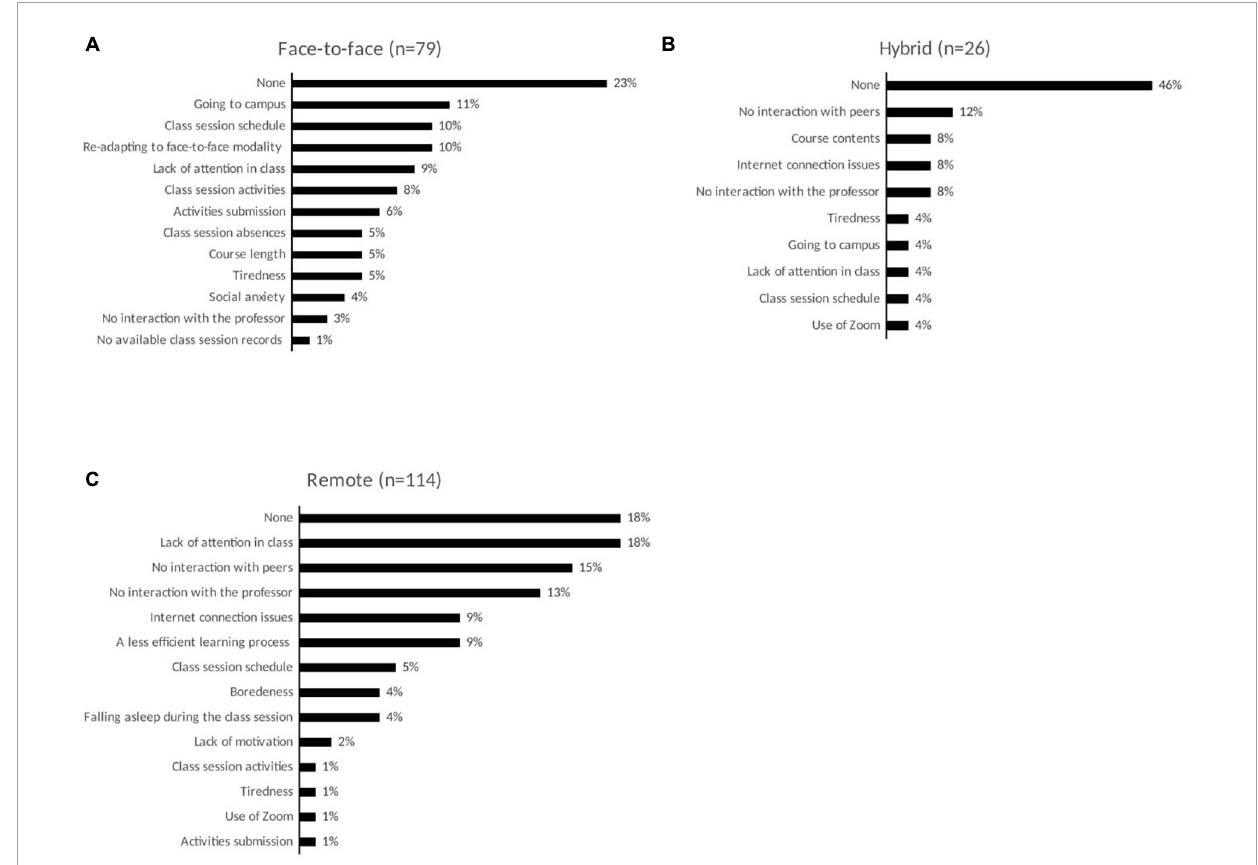
FIGURE2 Perceived factors hindering learning in each modality: face-to-face (A) , hybrid (B) , and remote (C)